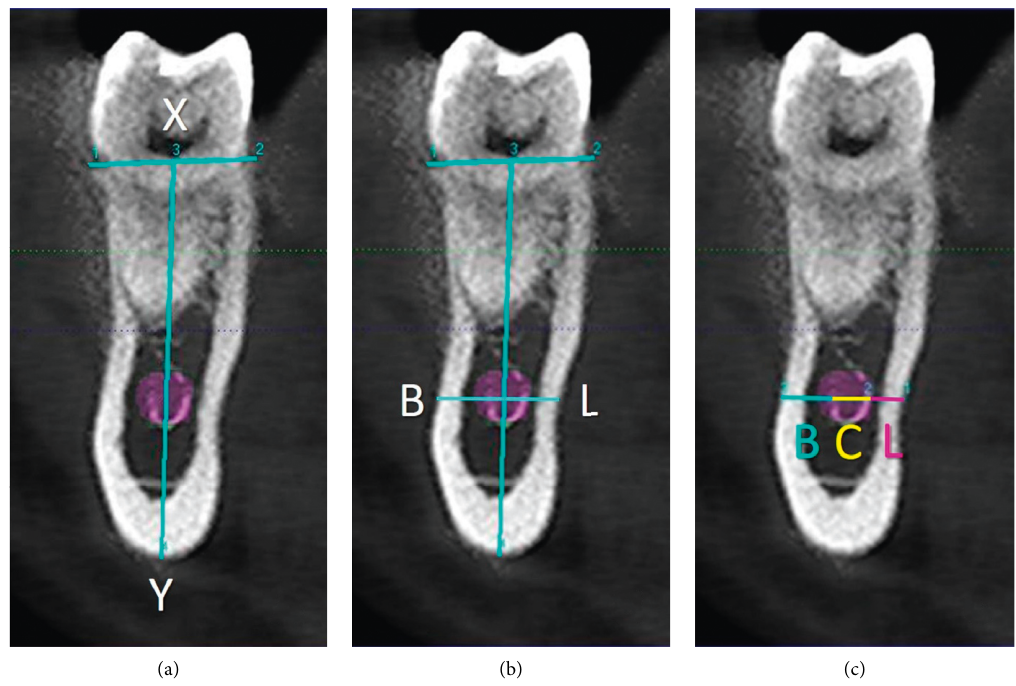
Figure 1: (a) Buccolingual position was determined by line XY; (b) line BL was plotted perpendicular to line XY; (c) buccal bone width (B), canal thickness (C), and lingual bone width (L) were measured along line BL at canal